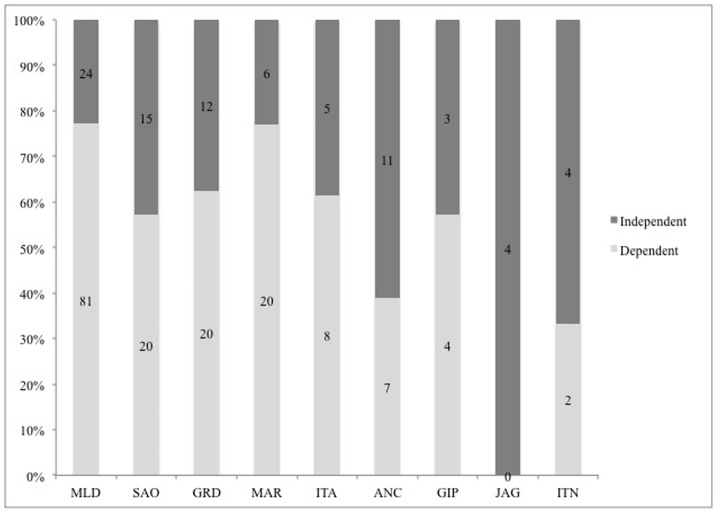
Percentage of frog species dependent and independent of water bodies for reproduction.Mainland (MLD), Ilha de São Sebastião (SAO), Ilha Grande (GRD), Ilha da Marambaia (MAR), Ilha Anchieta (ANC), Ilha de Itacuruçá (ITA), Ilha da Gipóia (GIP), Ilha de Jaguanum (JAG), Ilha de Itanhangá (ITN). Numbers on the bars indicate the actual number of species, and numbers in parentheses represent the area of the islands in ha.